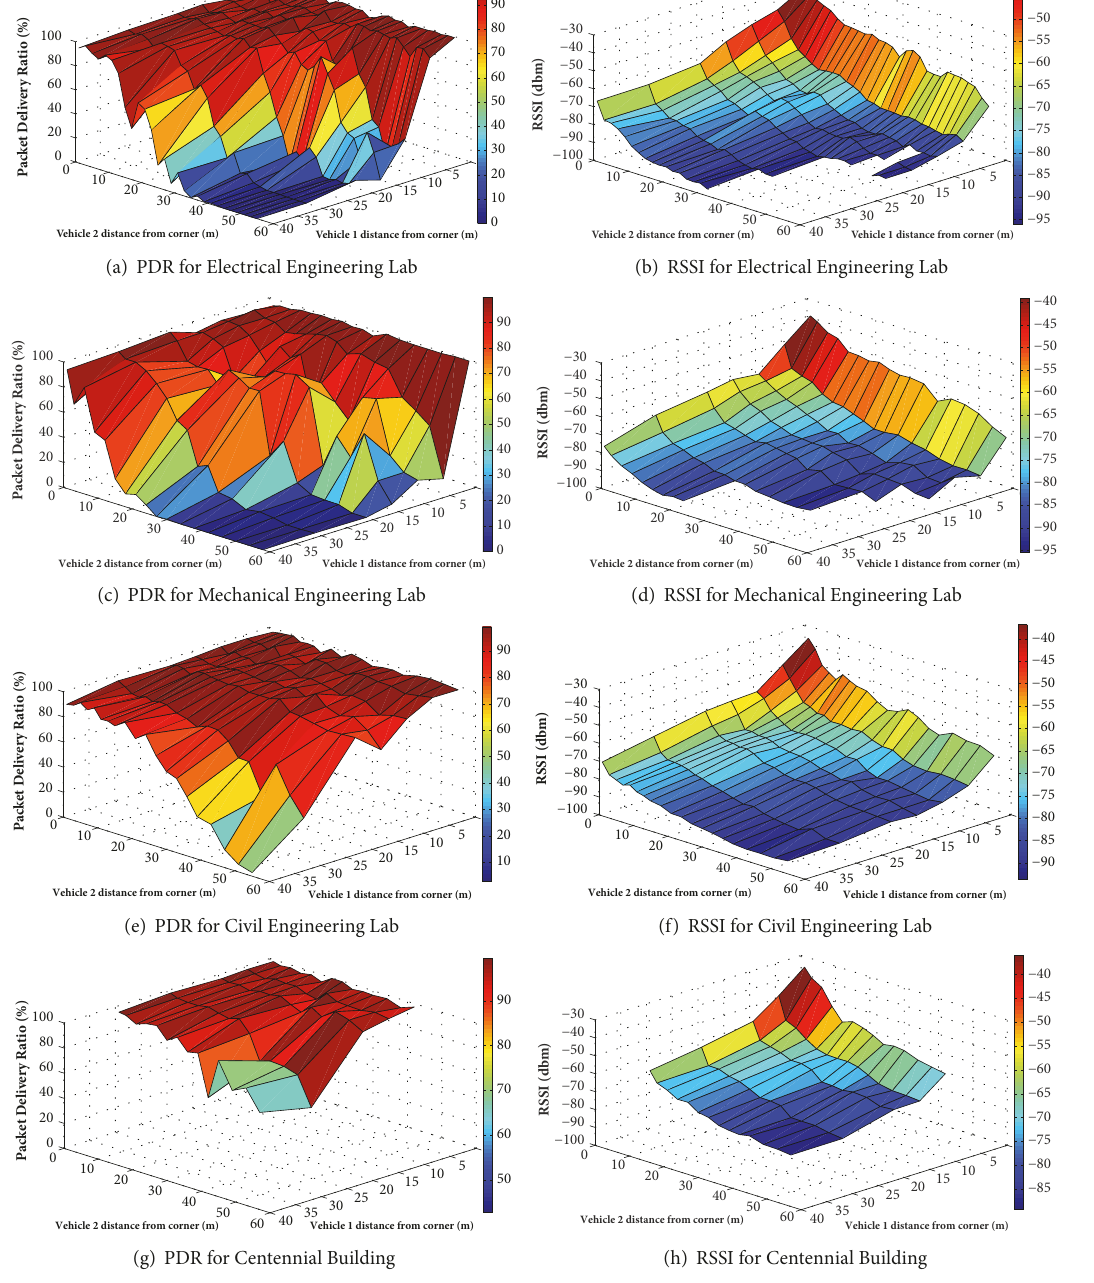
Figure 9: Results from real experiments. (a) PDR for Electrical Engineering Lab. (b) RSSI for Electrical Engineering Lab. (c) PDR for Mechanical Engineering Lab. (d) RSSI for Mechanical Engineering Lab. (e) PDR for Civil Engineering Lab. (f) RSSI for Civil Engineering Lab. (g) PDR for Centennial Building. (h) RSSI for Centennial